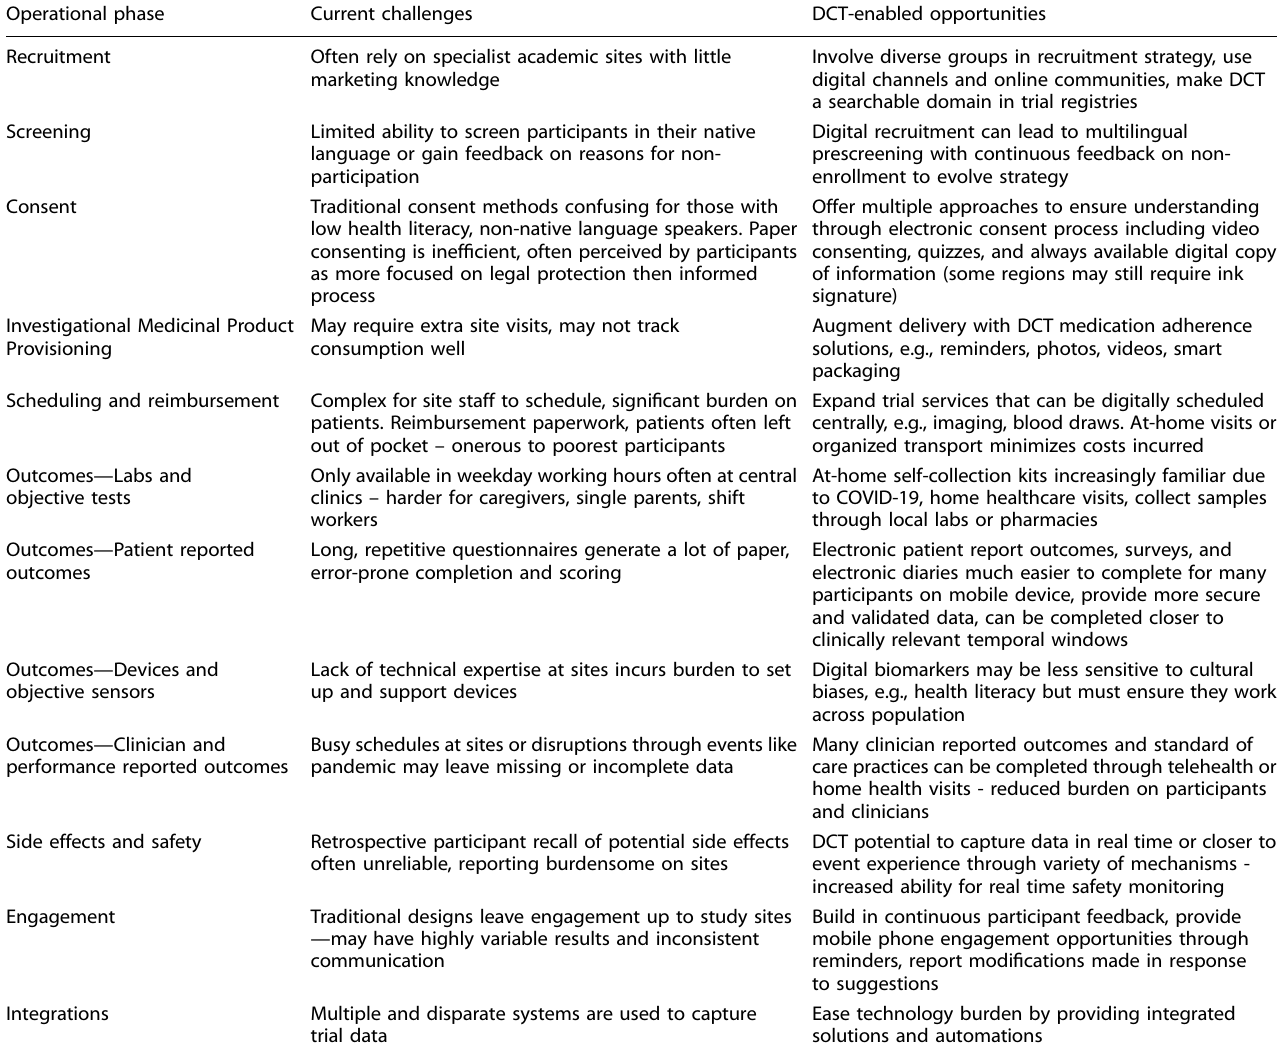
Table 1. Opportunities for DCT to enhance inclusivity in the operational phases of a